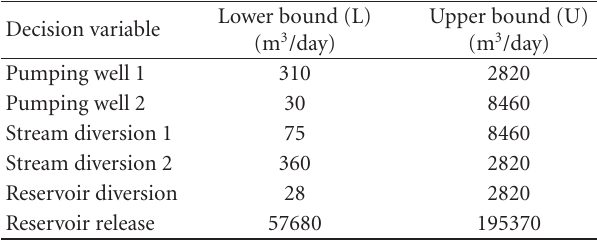
Table 4: Bounds on decision variables in stress period